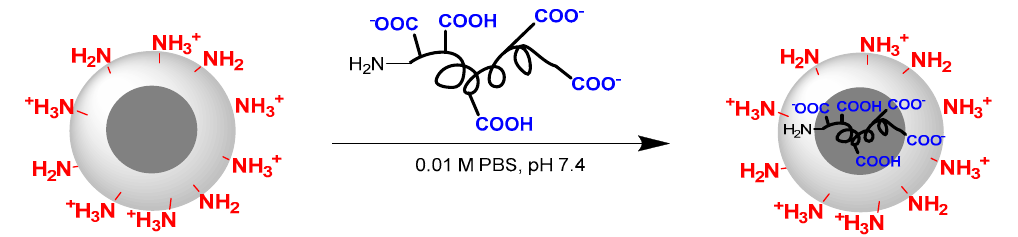
Figure 6. Scheme of encapsulation of C-peptide into the P(Lys- co - D Phe) nanospheres.